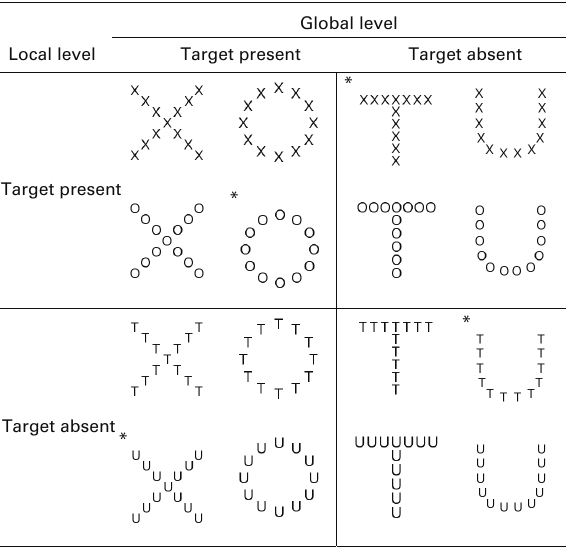
Table 1 | Experimental stimuli, hierarchical form displays of global target-present (large letters X and O) and global target-absent items (large letters T and U) composed of local target-present (small component Xs and Os) and local target-absent items (small component Ts and U).